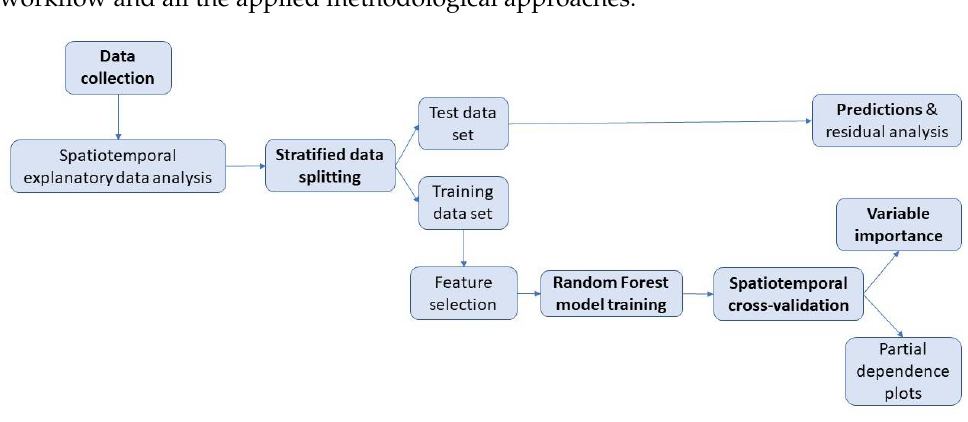
Figure 1. Workflow for the present study.